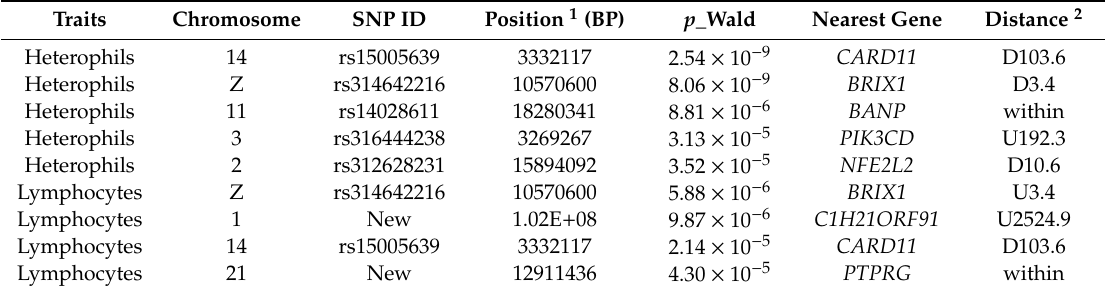
Table 3. SNPs with genome-wide significance for heterophil and lymphocyte traits.